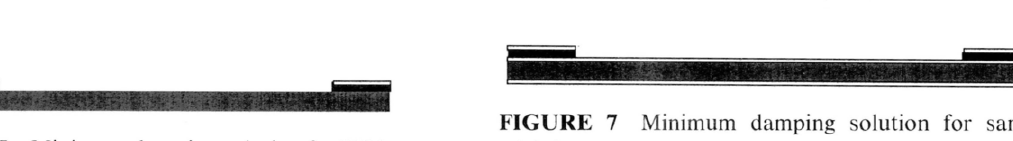
FIGURE 5 Minimum damping solution for PU beam.